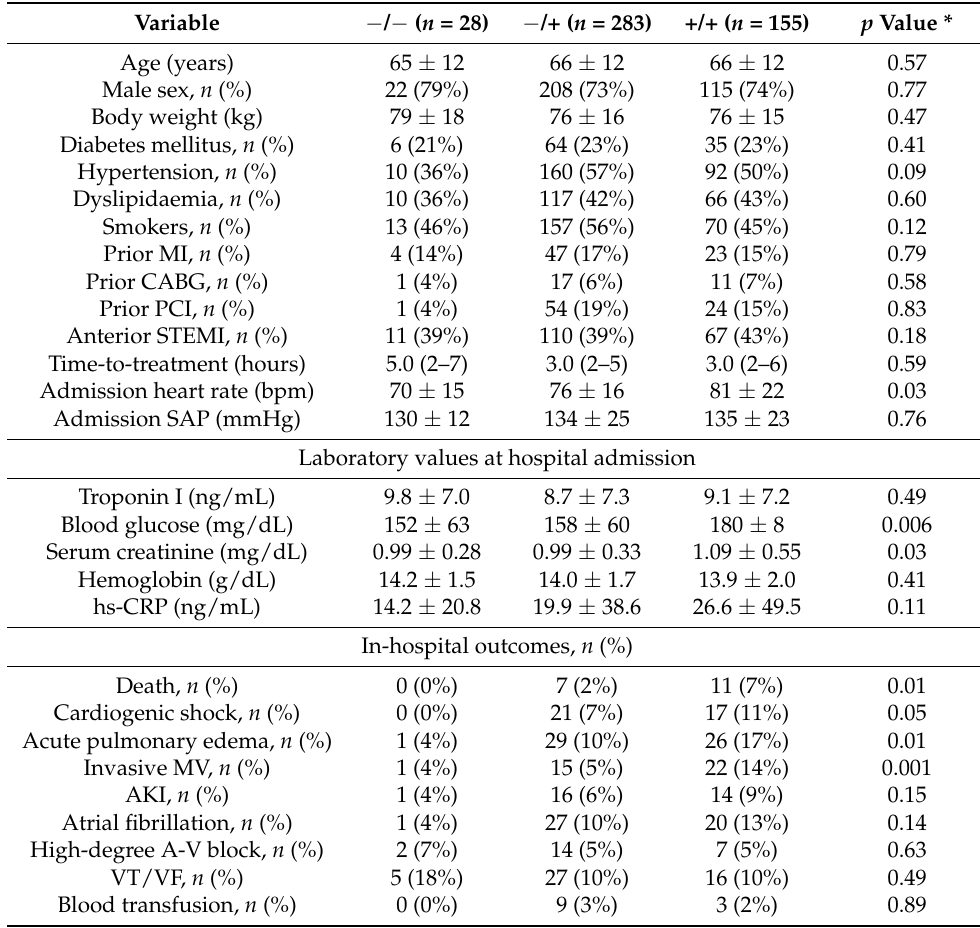
Table 1. Clinical characteristics and in-hospital outcomes of study patients grouped according to cytochrome c and/or cell-free mitochondrial DNA (mtDNA)